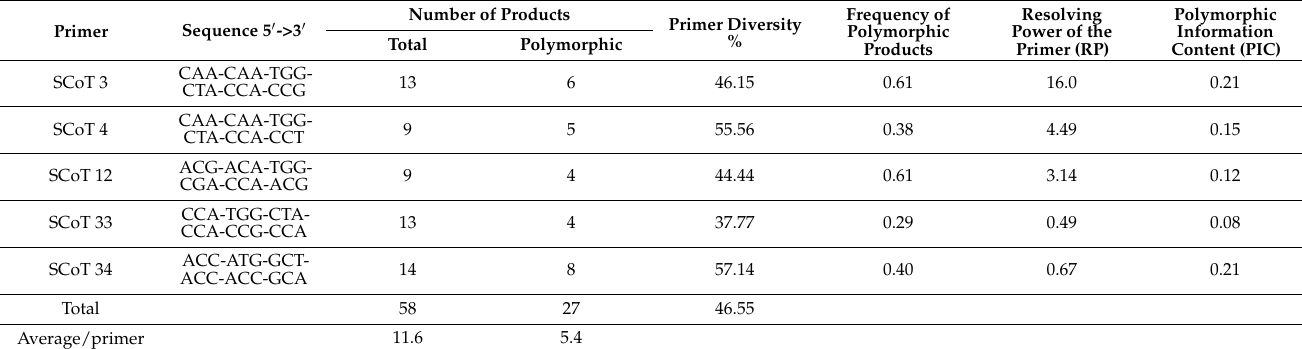
Table 3. Characteristics of the SCoT primers used to assess the genetic similarity of the analyzed oat cultivars. Primer Sequence 5 (cid:48) ->3